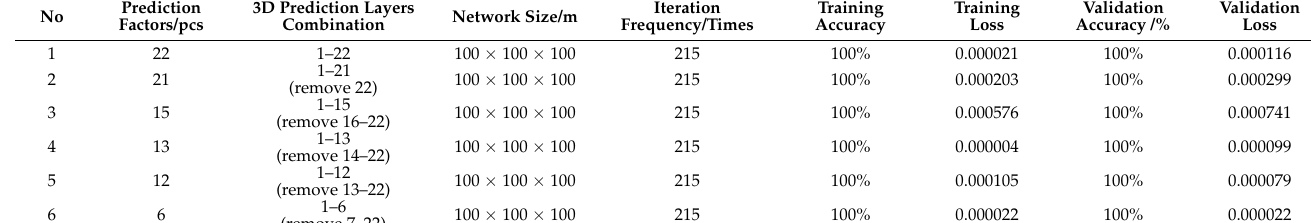
Table 8. Comparison of model indicators in the group test.